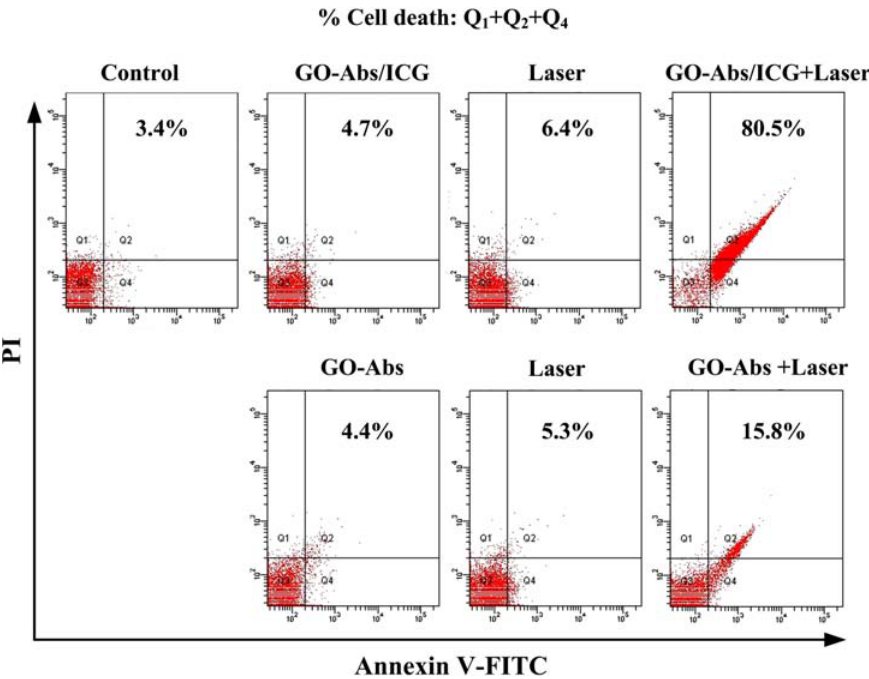
Fig. 5. The comparison of photoacoustic therapy e±ciency between GO-Abs/ICG and GO-Abs at the di®erent treatments. Analysis of apoptosis in di®erently treated U87-MG cells was performed by °ow cytometry with annexin-V/PI double staining